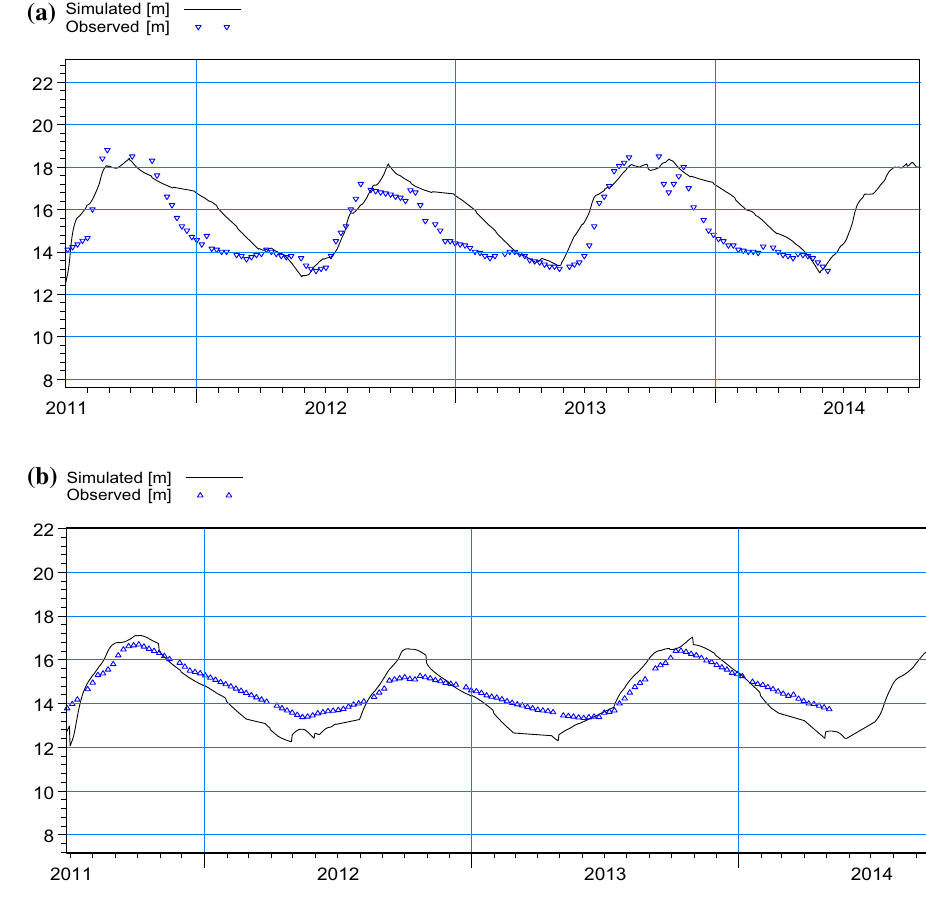
Fig. 8 The river–groundwater integrated model was calibrated against observed groundwater level data obtained for monitor- ing wells a GT7066013 and b GT7066016. The model was calibrated for 2011–2013 period